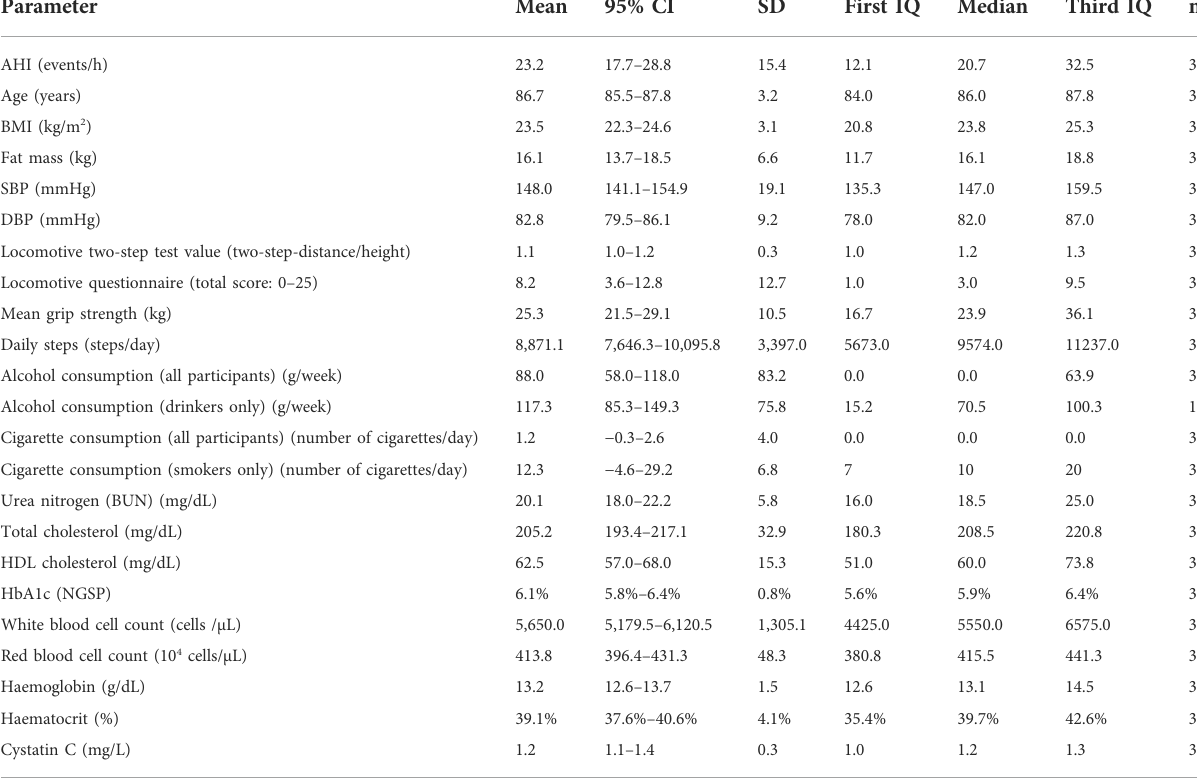
TABLE 2 Apnoea-hypopnoea index (AHI)-related factor pool of continuous AHI values. Explanatory variables for AHI